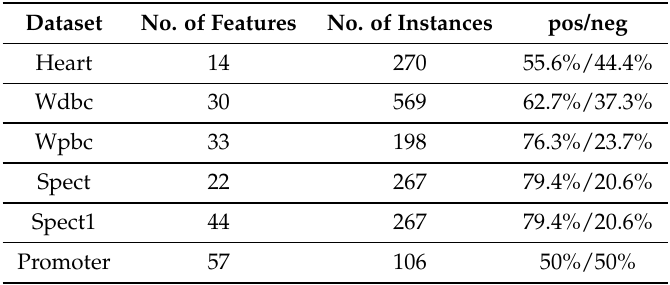
Table 2. Datasets used in the experiment. pos, positive; neg, negative.